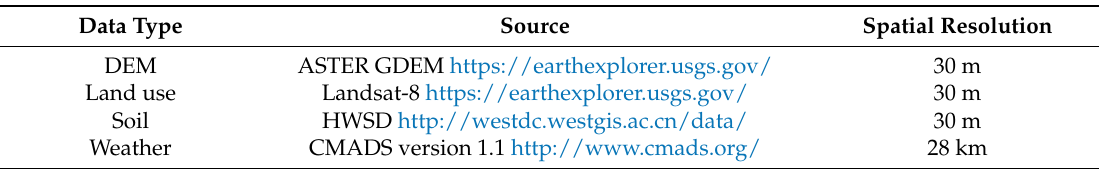
Table 1. Data description for the study area.